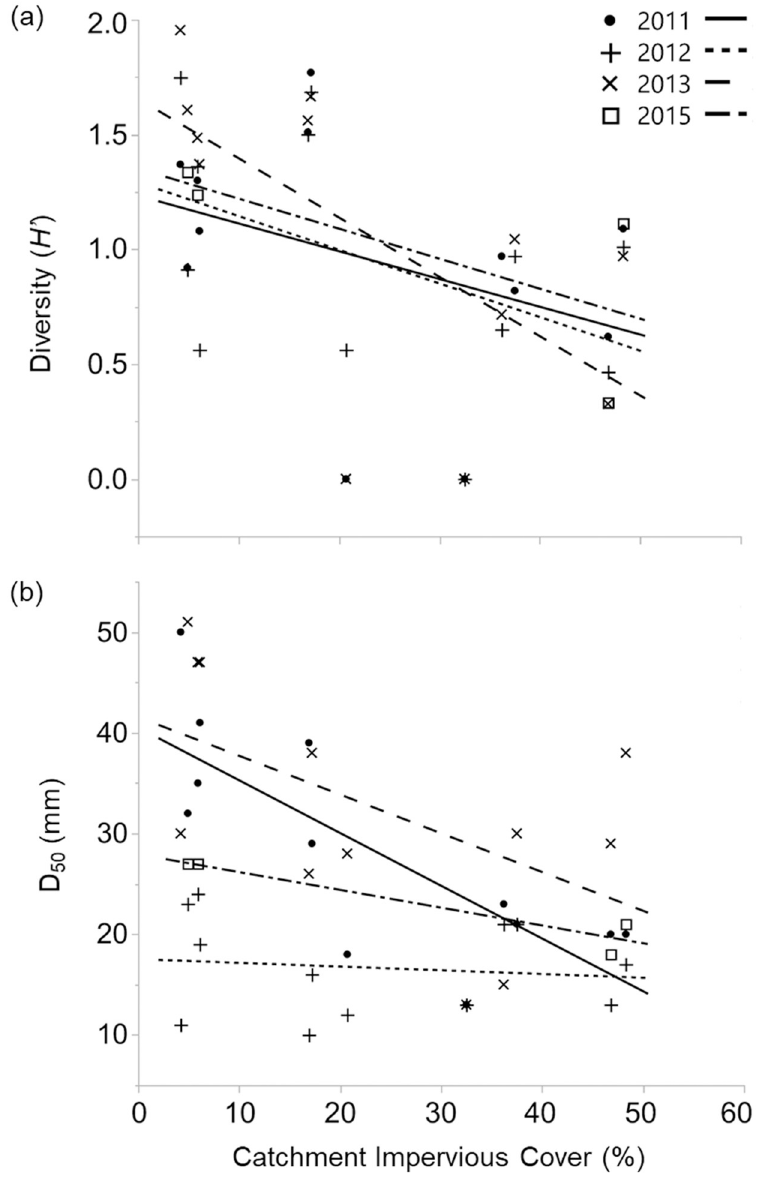
Fig 6. Linear relationships between % catchment imperviousness and Δ fish assemblage and hydrogeomorphic variables. Linear relationships by year between % catchment imperviousness and (a) diversity ( H’ ; 2011: R 2 = 0.14, F = 1.57, p = 0.239; 2012: R 2 = 0.20, F = 2.56, p = 0.141; 2013: R 2 = 0.41, F = 6.96, p = 0.025; 2015: R 2 = 0.48, F = 1.88, p = 0.304) and (b) D 50 (2011: R 2 = 0.61, F = 15.33, p = 0.003; 2012: R 2 = 0.02, F = 0.16, p = 0.699; 2013: R 2 = 0.28, F = 3.87, p = 0.077; 2015: R 2 = 0.91, F = 20.72, p =